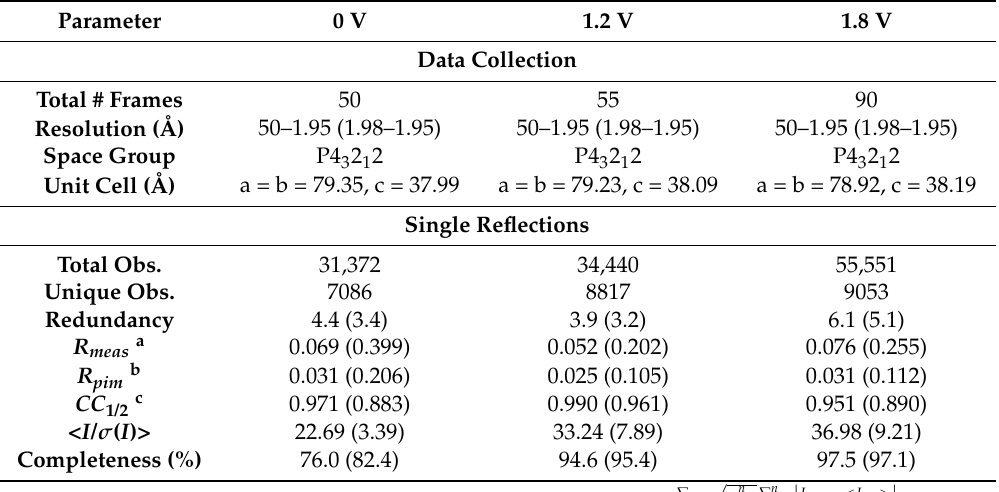
Figure 6. ( a ) A typical obtained X-ray diffraction pattern and ( b ) a magnified view showing details of diffracted spots. ( c ) Pixel intensity along the blue line in the inset indicated the high levels of signal-to-noise observed in the data. ( d ) A plot of signal-to-noise ratios at different resolution shells of diffraction patterns from crystals grown under different voltages. Table 1. Crystallographic statistics for data obtained using graphene-based microfluidics under different applied